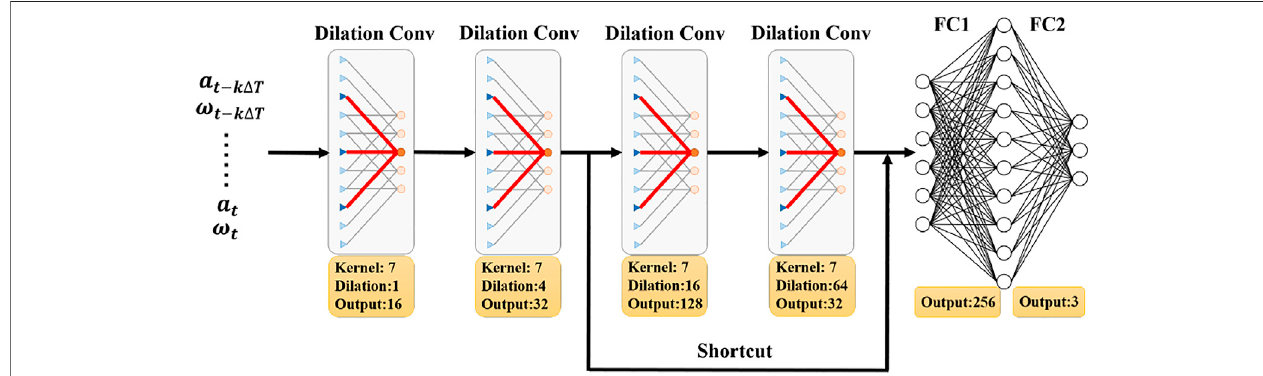
FIGURE2| ThedetailsoftheCalib-Net structure.TheproposedCalib-Nettakestemporalgyroscopemeasurementsandaccelerometermeasurementsasinputs, and outputs the compensation part for angular velocity measurements.